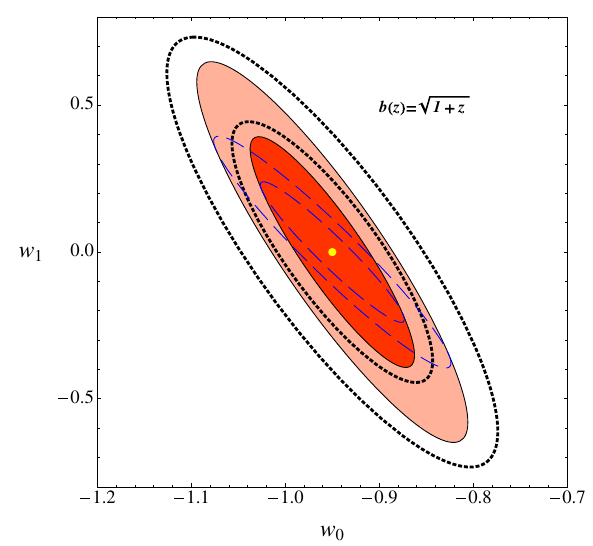
Fig. 24 Errors on the equation of state. 1 and 2 σ marginalized probability regions for the parameters w w 0 and 1 , relative to the reference case and bias b fixing γ 0 ,γ 1 and Ω k = 0 to their fiducial values and marginalizing over all the other parameters; for the red shaded ellipses instead, we also marginalize over Ω k = 0 but we fix γ 0 ,γ 1 . Finally, the black dotted ellipses are obtained marginalizing over all parameters but w 0 and w 1 . The progressive increase in the number of parameters reflects in a widening of the ellipses with a consequent decrease in the figures of merit (see Table 11) Table 11 1 σ marginalized errors for the parameters w 0 and w 1 , obtained with three different methods (reference case, see Fig. 24) γ ,γ Ω 0 1 , k